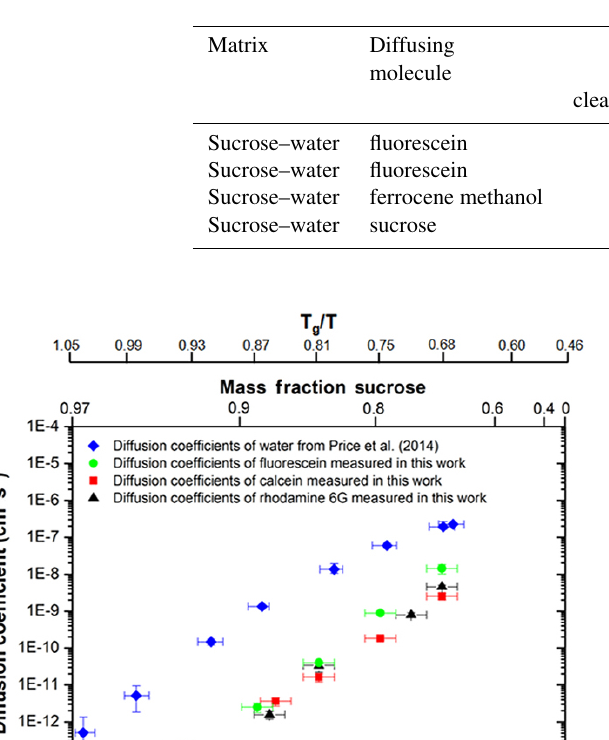
Table 2. Summary of results from previous studies that tested the breakdown of the Stokes–Einstein relation using organics or organometallics in sucrose–water mixtures.